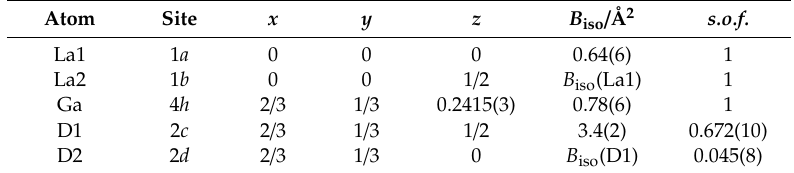
Table 1. Structural parameters of LaGa 2 D 0.71(2) , space group P 6 / mmm , a = 4.3287(3) Å, c = 8.6910(5) Å.